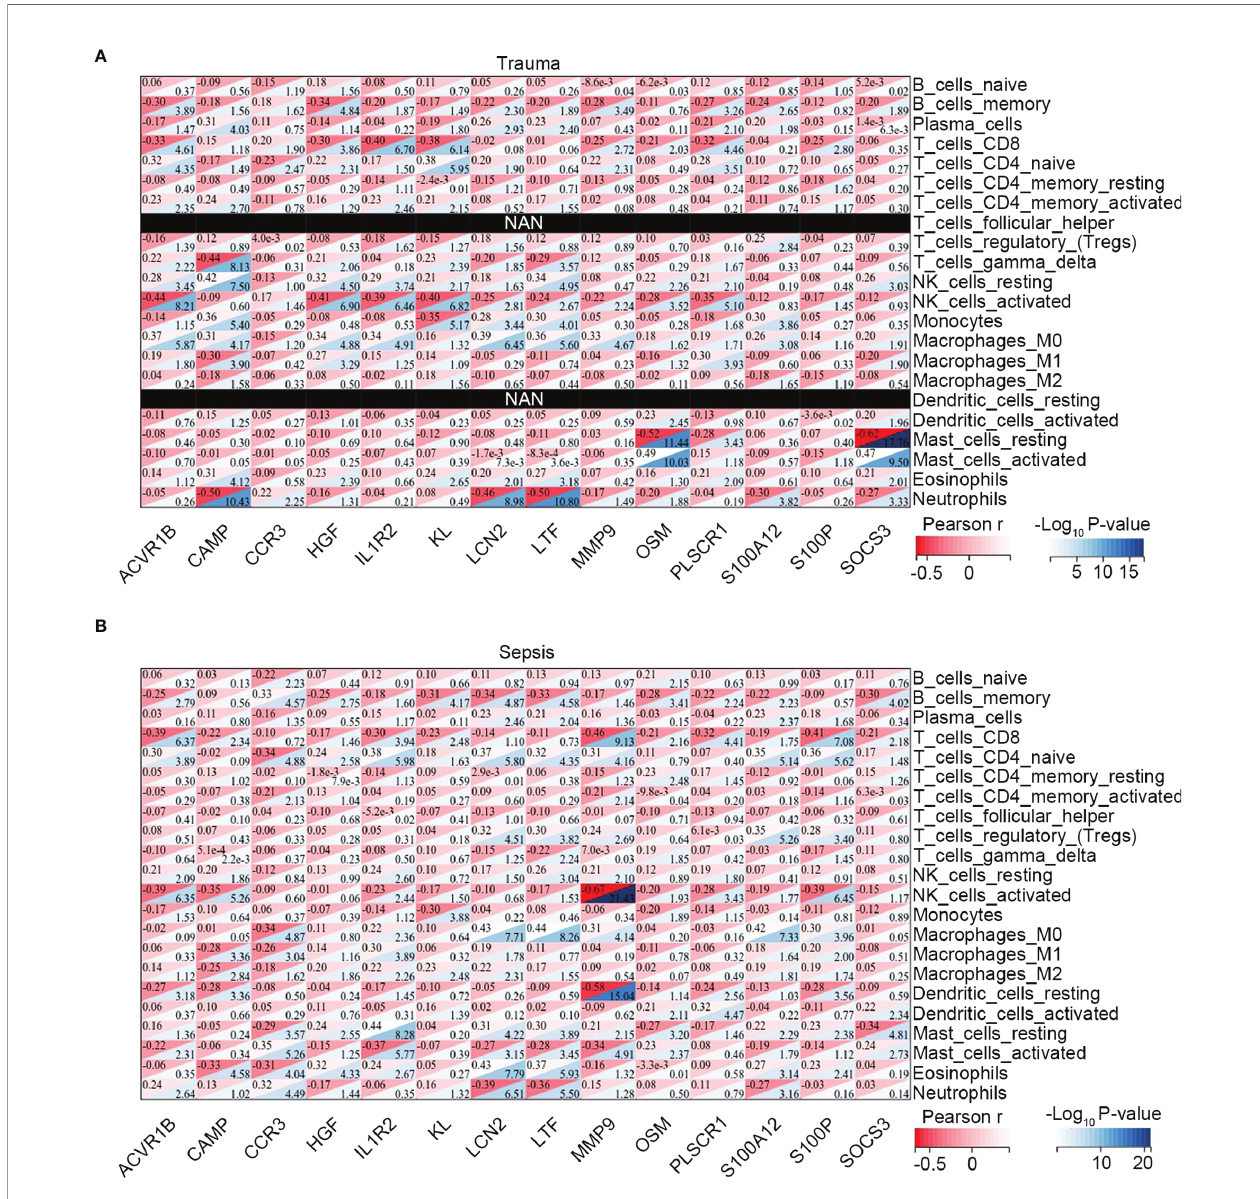
FIGURE 3 | Association between the immune-related common genes and the immune cell fractions. Associations identi fi ed in (A) trauma, and (B)